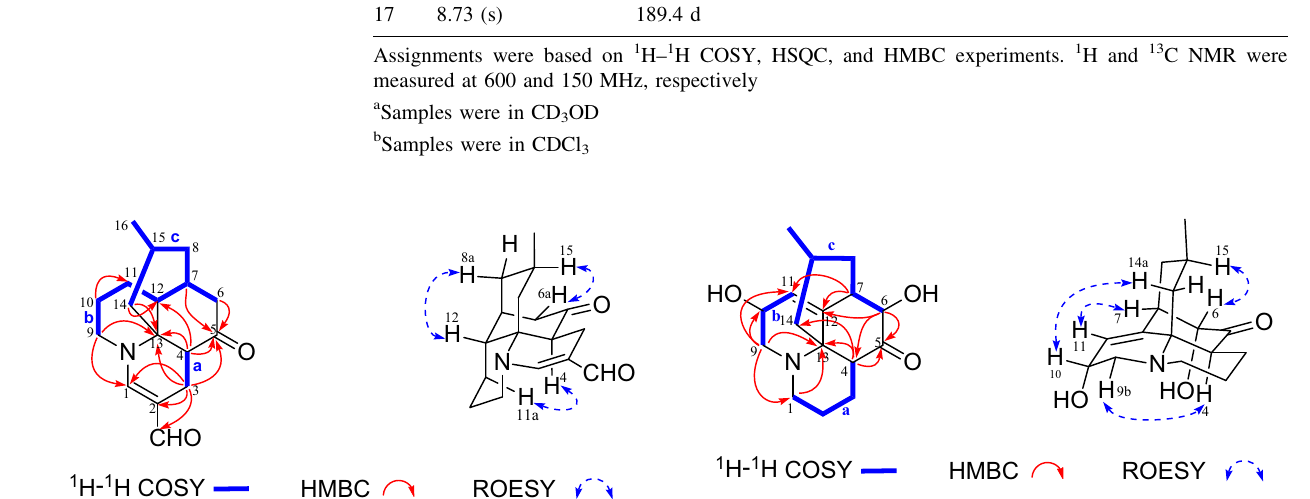
Fig. 3 Key 2D-NMR correlations for compound